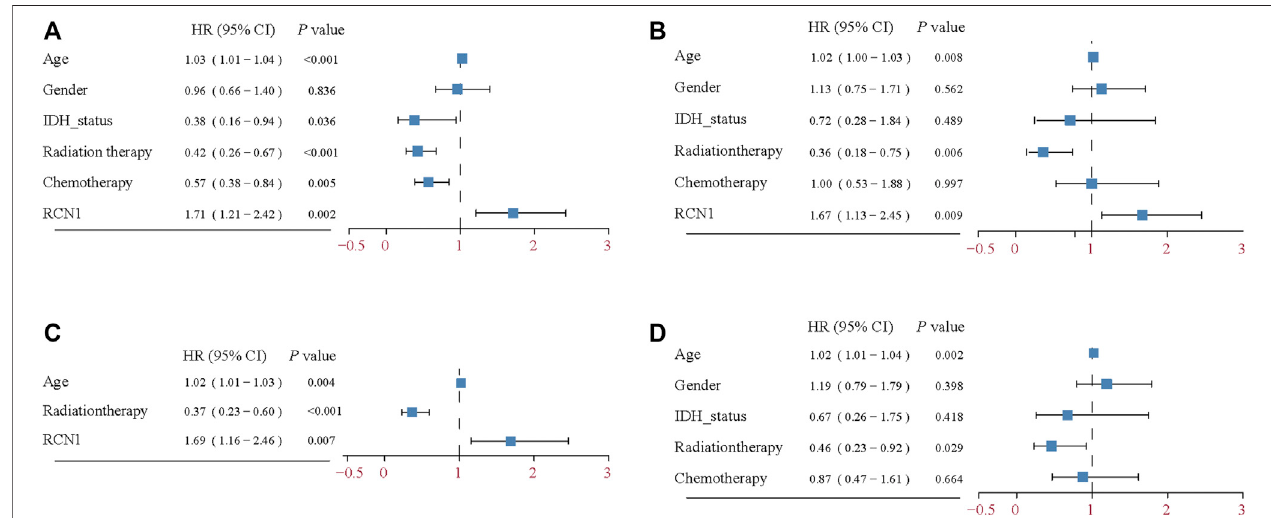
FIGURE 3 | Forest plot of the Cox regression analysis. (A) Univariable Cox regression analysis for the training cohort. (B) Multivariable Cox regression analysis for the training cohort. (C) Multivariable Cox regression analysis for adjusted I model in the training cohort. (D) Multivariable Cox regression analysis for clinical features in training cohort.